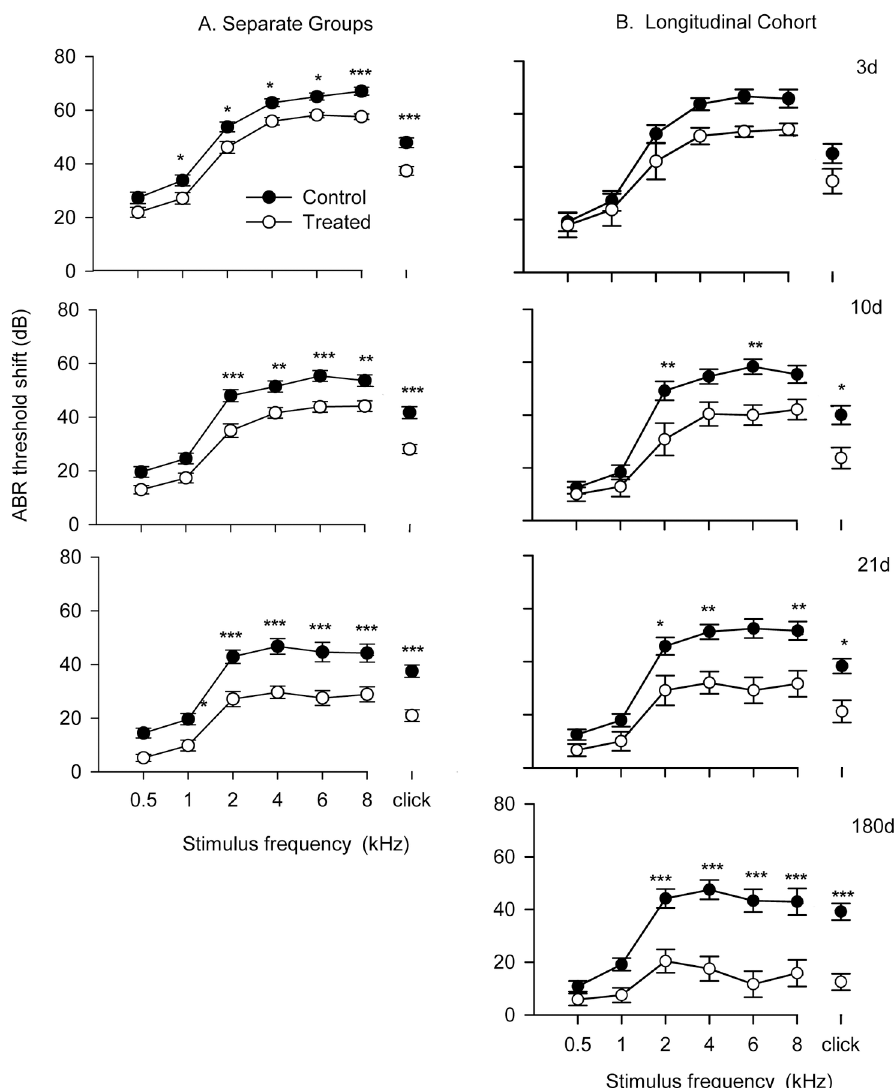
Fig 1. ABR threshold shift as a function of stimulus frequency for noise exposed-untreated (control) and—HPN-07 treated (treated) chinchilla 3, 10, 21 and 180 days after noise exposure. The number of chinchillathat were tested (both ears) at each time point (separate groups) were as follows: 3d (25); 10d (19); 21d (13); 180d (6). In the “longitudinal cohort study” the same six animals(12 ears) were tested at each time point. The symbols with horizontal bars represent the means and SEM of ABR threshold shift at individual stimulus frequency and Click (CLK) stimulus. The filled and unfilledsymbols indicatenoise exposed-untreated and HPN-07-treated groupsrespectively.Two-way ANOVA and Bonferroni Post Hoc test were applied( * , ** , *** indicatesignificantlevel of P < 0.05, 0.01 and 0.001 respectively). The data show that HPN-07 treatment reducedABR thresholdshifts to a similar degreeat each frequencyand time point in both experimental